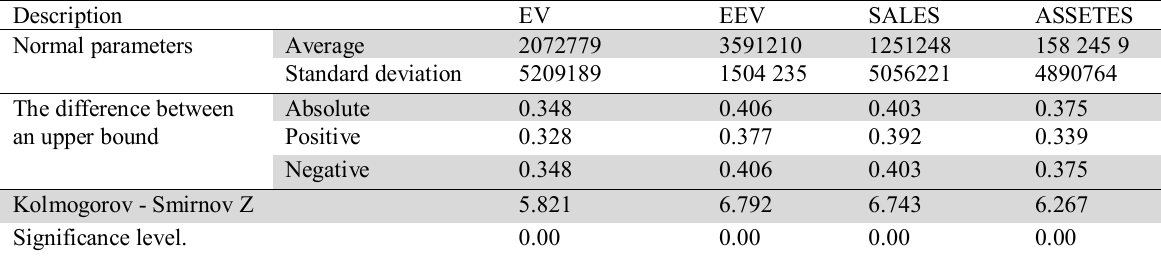
Summary of results of normality test of variable distribution